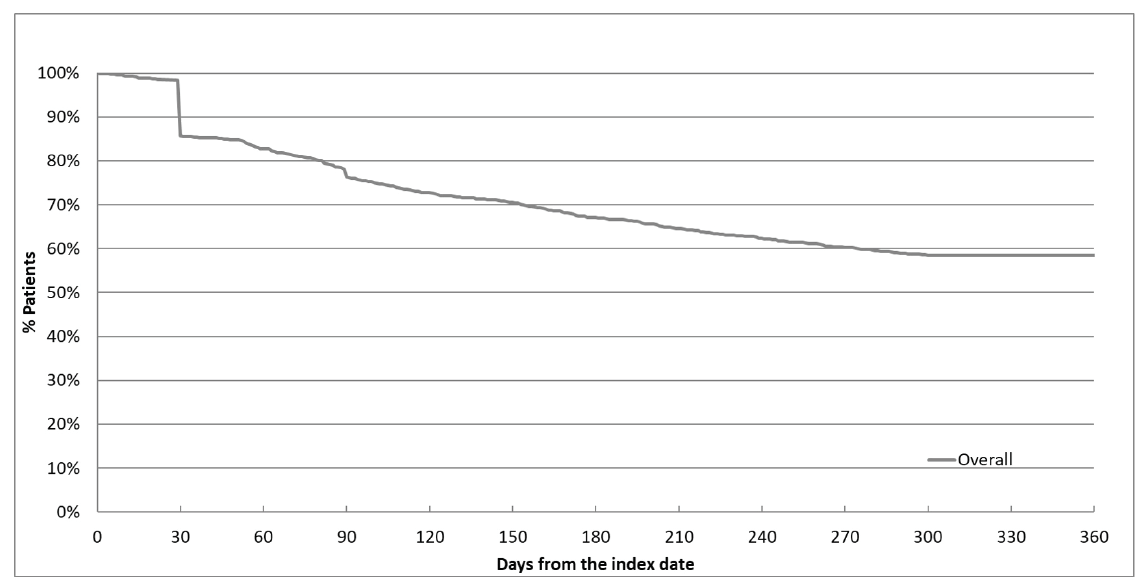
Figure 2. Kaplan-Meier Analysis: Time to Treatment Modification 12 Month Post-index Date Kaplan-Meier analysis of time to treatment discontinuation, medication switch, treatment augmentation or end of study period during the 12-month post-index